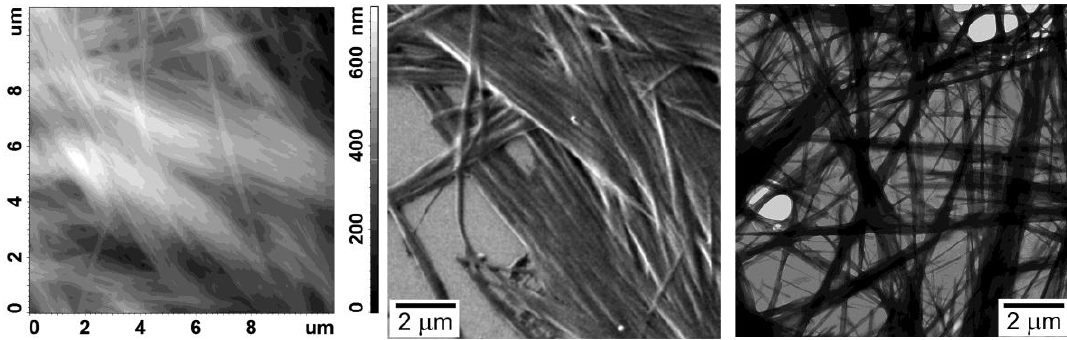
Figure 6. AFM, SEM, and TEM images for the dried gel benzene@4ce*HCl . The sample of benzenogel benzene@4cb*HCl was subjected to different solvent removal procedures.